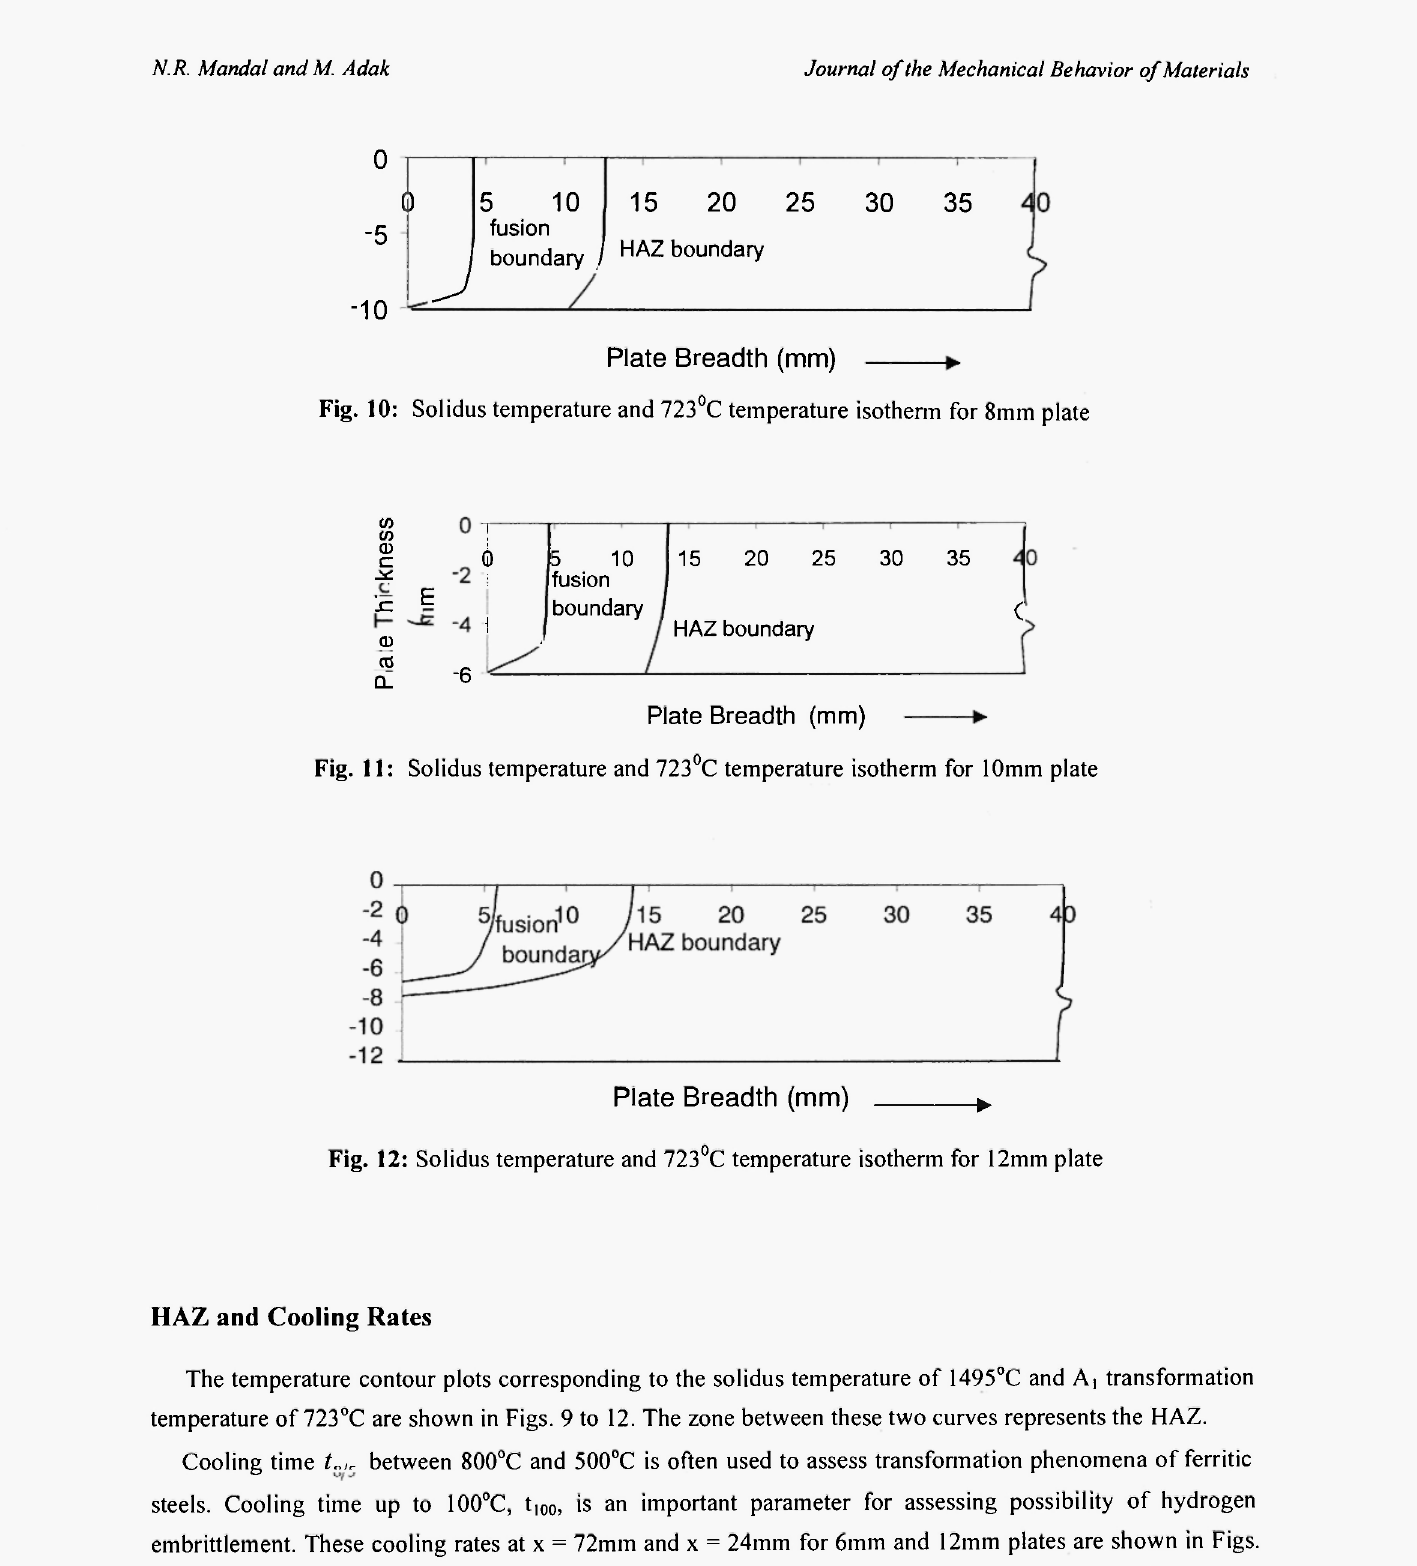
Fig. 10: Solidus temperature and 723°C temperature isotherm for 8mm plate